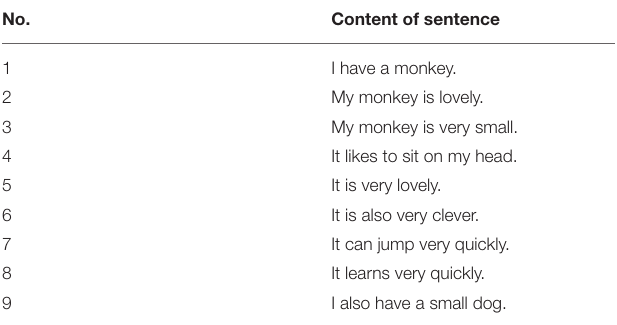
TABLE 1 | Example of